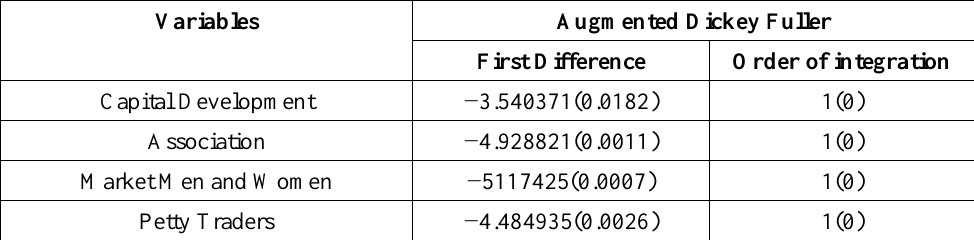
Table 5. Unit Root Test Results (authors’ computation,